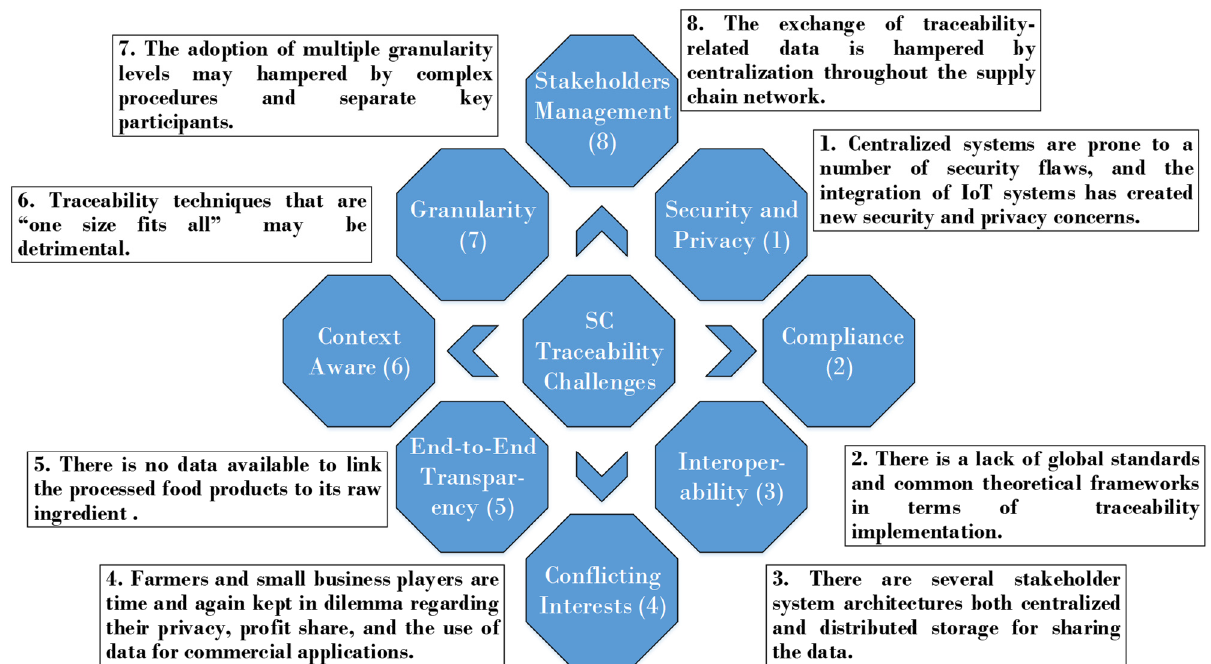
Figure 4. Supply chain (SC) traceability challenges .